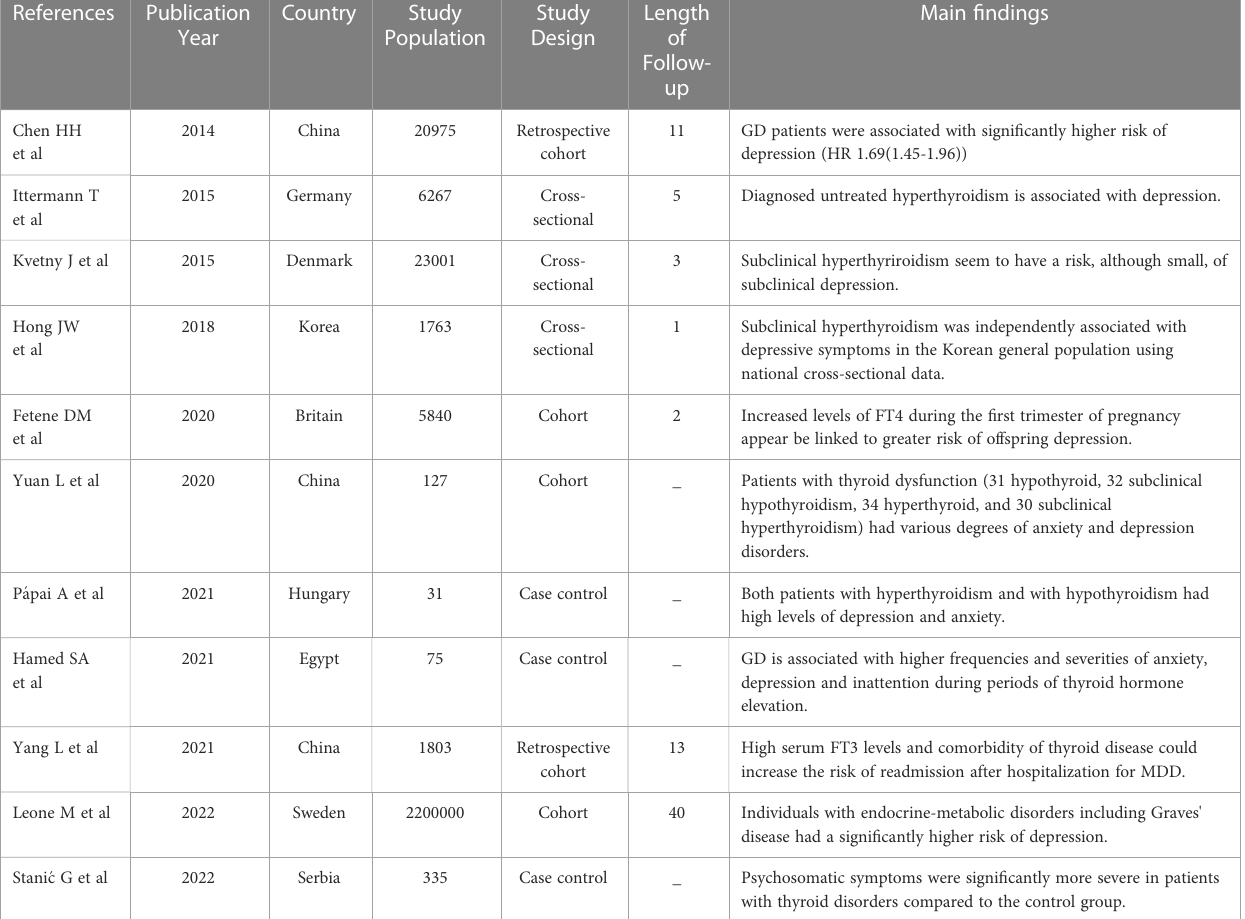
TABLE 1 Clinical studies of Graves' disease related to depression.